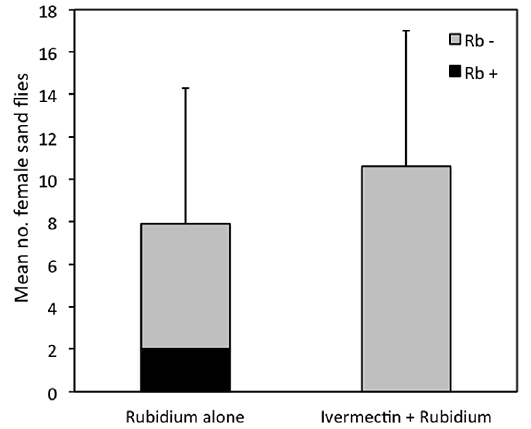
Figure 5. The mean number of females of P.papatasi captured per night and the mean number of sand flies that was positive for the presence of rubidium at sites treated with rodent bait containing rubidium plus ivermectin or rubidium